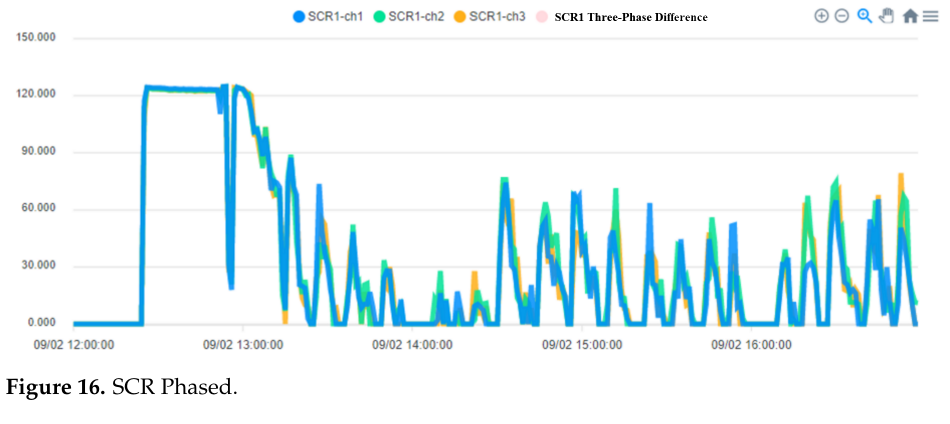
Figure 16. SCR Phased.